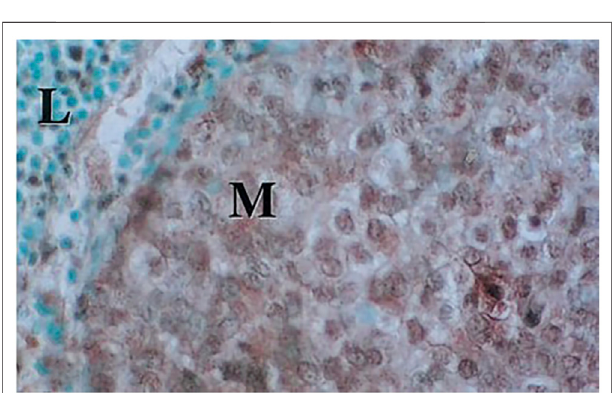
FIGURE4| Lymphnodewithmetastaticbreastcarcinoma.Samplewas processedasin Figure2 .Notebothcytoplasmicandnuclearstainingfor β IIin the metastatic tumor cells (M) and some weak nuclear staining for β II in the adjacent lymphocytes (L). (From Yeh and Ludueña, 2004).